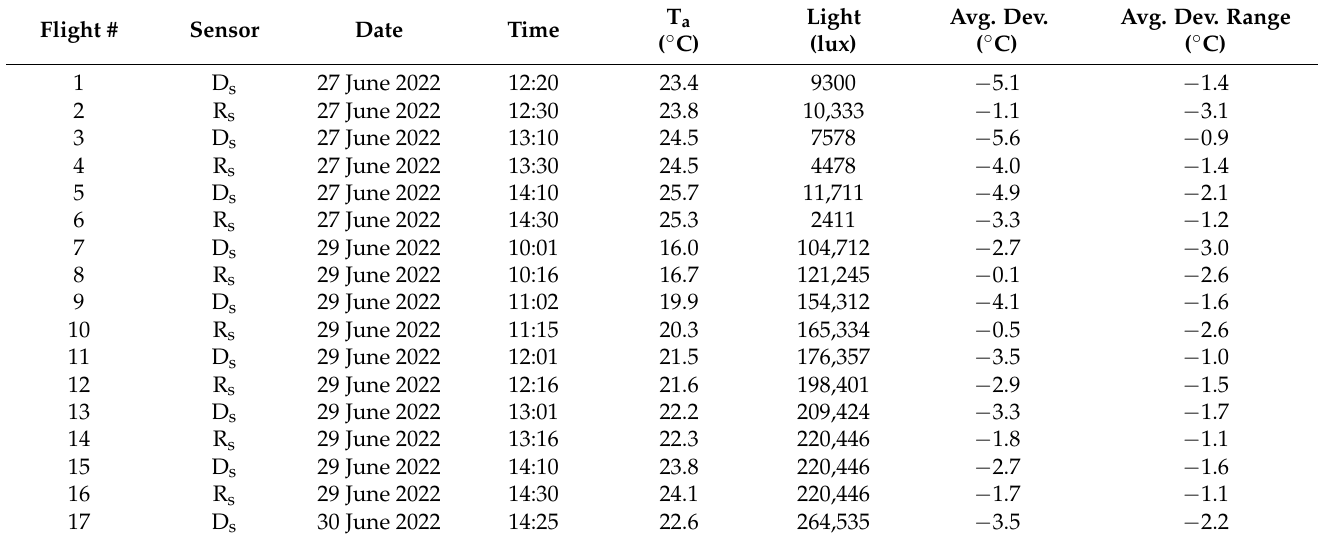
Table 2. The air temperature (T a ) and light intensity conditions (lux) are provided for each flight, in concert with sensor specific average deviations (Avg. dev. ◦ C) and average deviation ranges (Avg. dev. range ◦ C). The Avg. dev. (sensory accuracy metric) was calculated as the radiant temperature (T R ) minus the kinetic temperature (T K ) for each flight averaged across the n = 12 instream loggers. The Avg. dev. range is simply the range of Avg. dev. for each flight calculated by T R minus T K and represents sensor precision. # is the flight